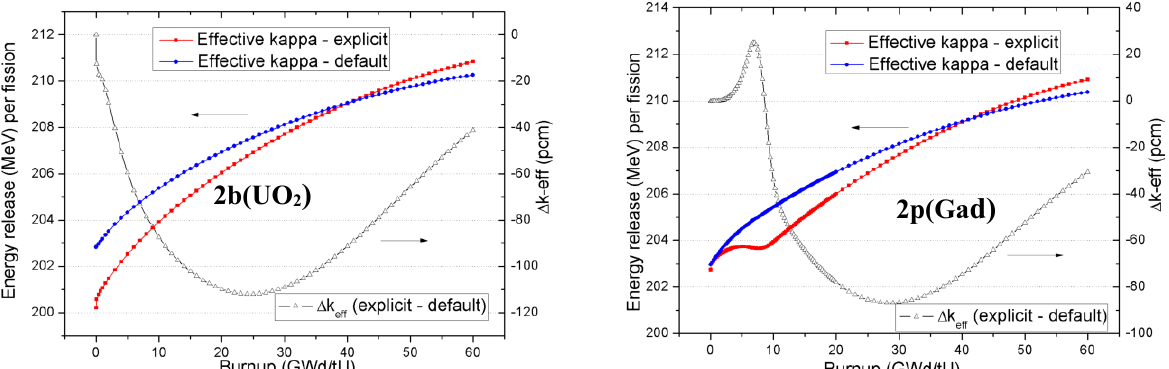
Figure 4. Effective kappa and k eff in depletion for VERA Problem 2b (left) and 2p